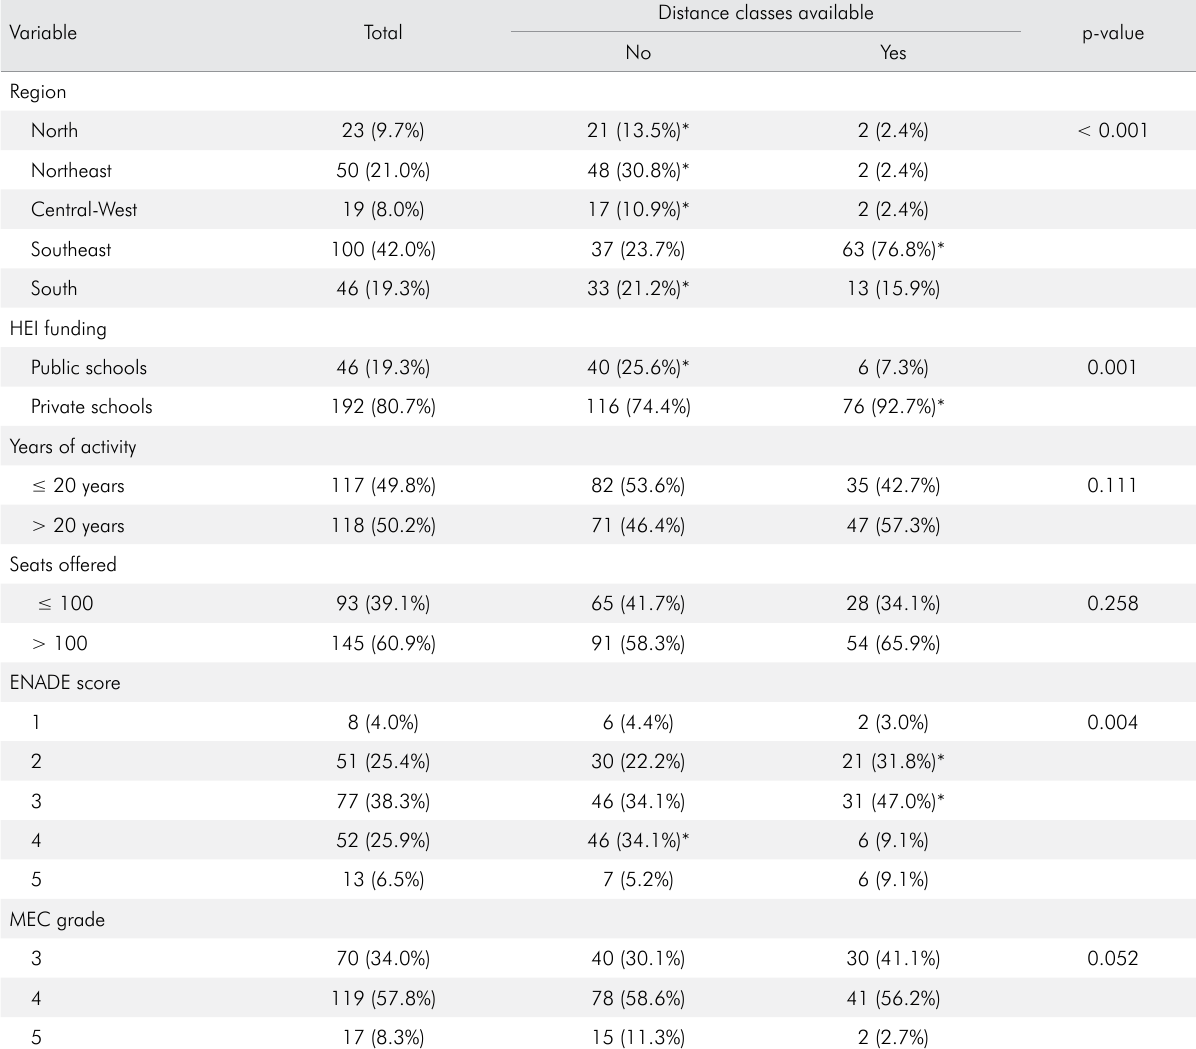
Distance classes